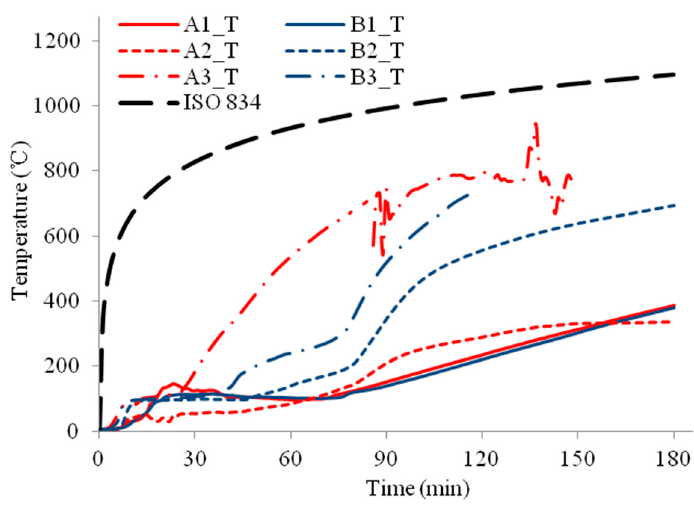
Figure 11. Temperature profiles at the medium section for HSS-C2.